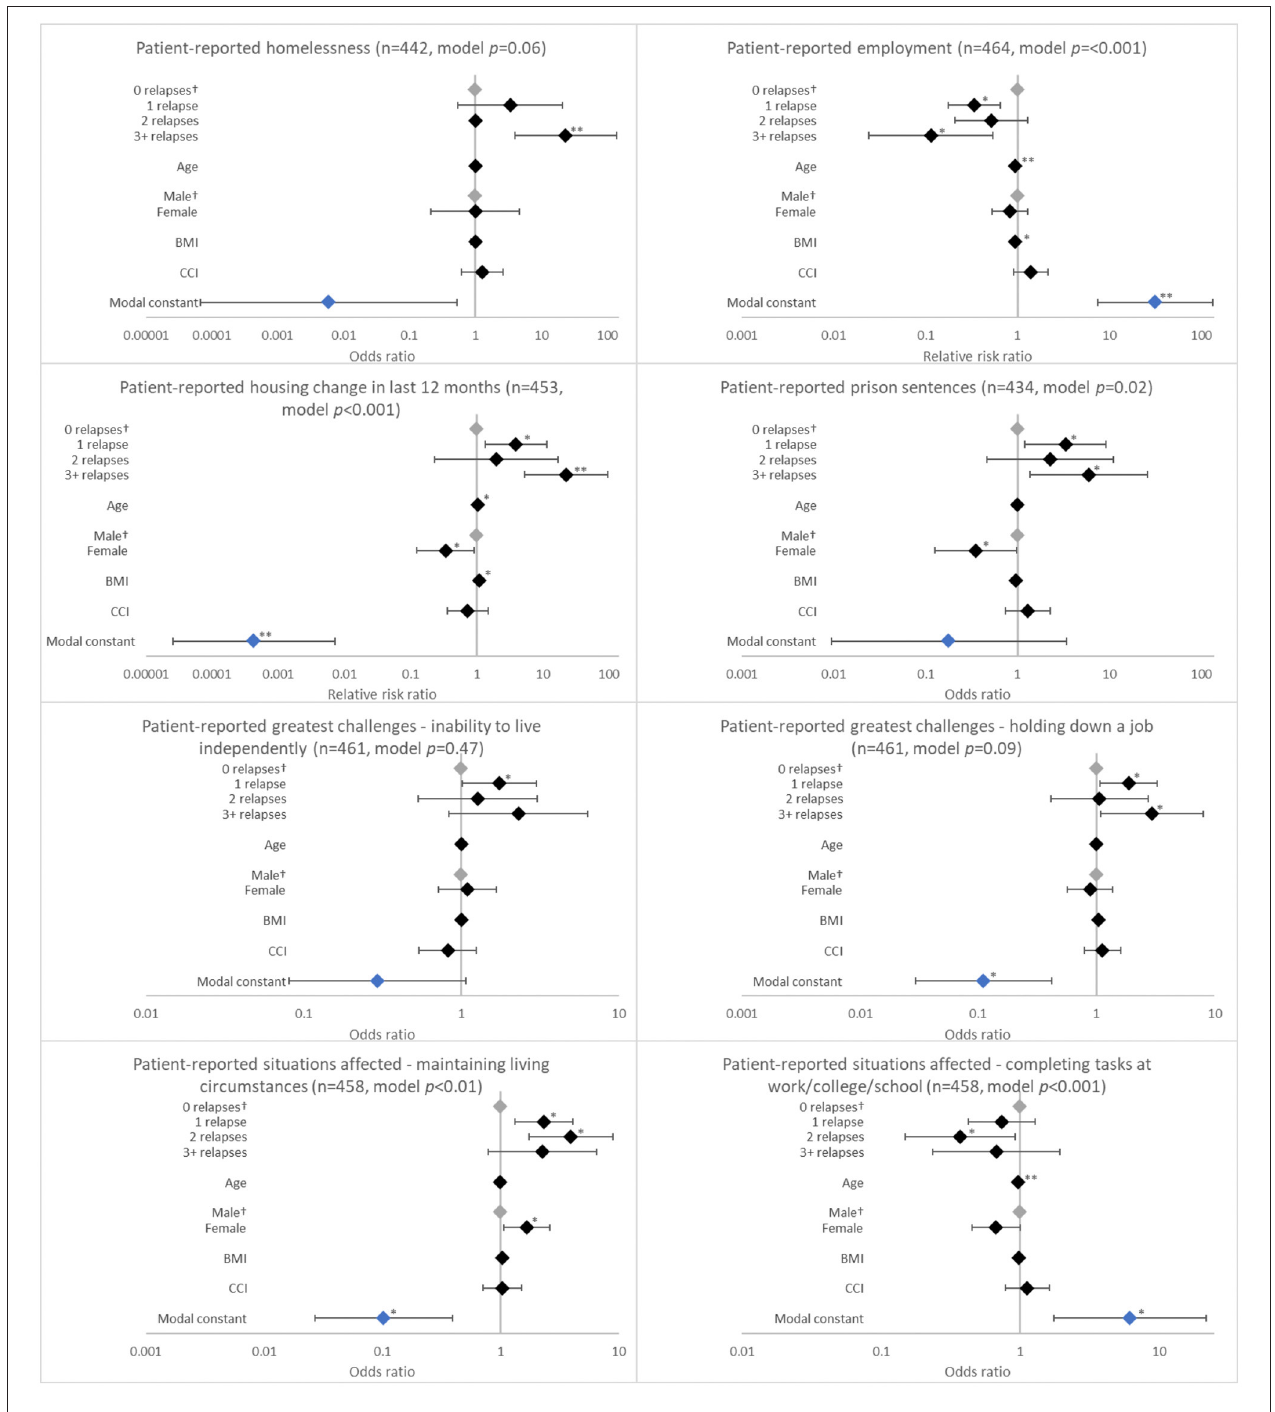
FIGURE 1 | Association between patient-reported psychosocial outcomes and the number of relapses in the last 12 months. † Base level, * p < 0.05 and ** p < 0.001. Likelihood ratio p -values are referenced in Table 2 . BMI, body mass index; CCI, Charlson comorbidity index. Grey diamonds indicate base level. Blue diamond indicates the model